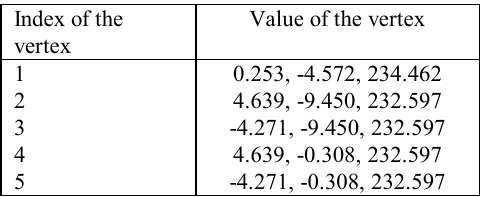
Table 6. Map of the index of each vertex and its 3D value for